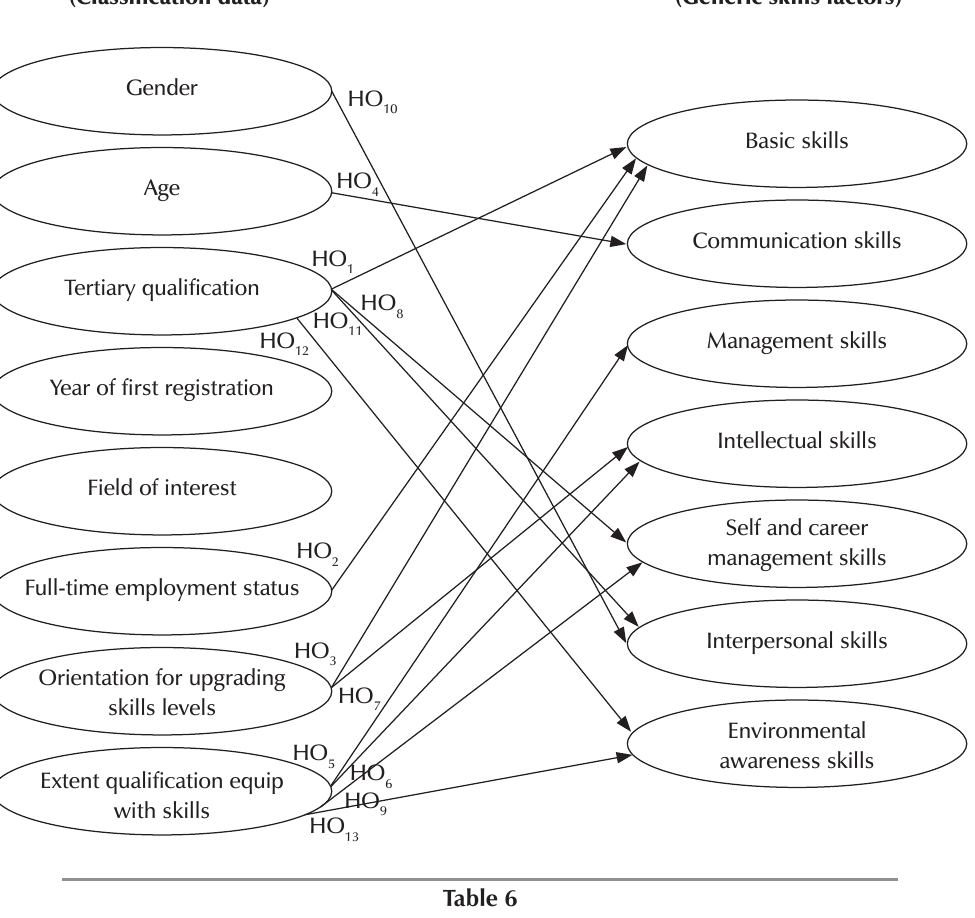
Analysis of variance for generic skills and the independent variables (classification data) Independent